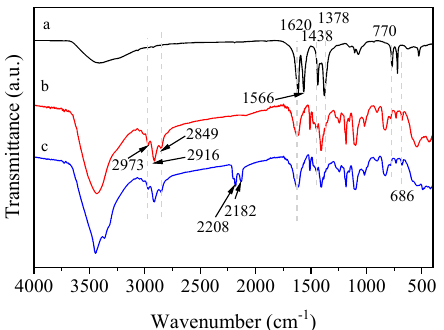
Figure 1. Fourier transform infrared (FTIR) spectra of the HKUST-1 ( a ), TEBAC-HKUST-1 ( b ), and TEBAC-HKUST-1-Pt(CN) 42 − ( c ).